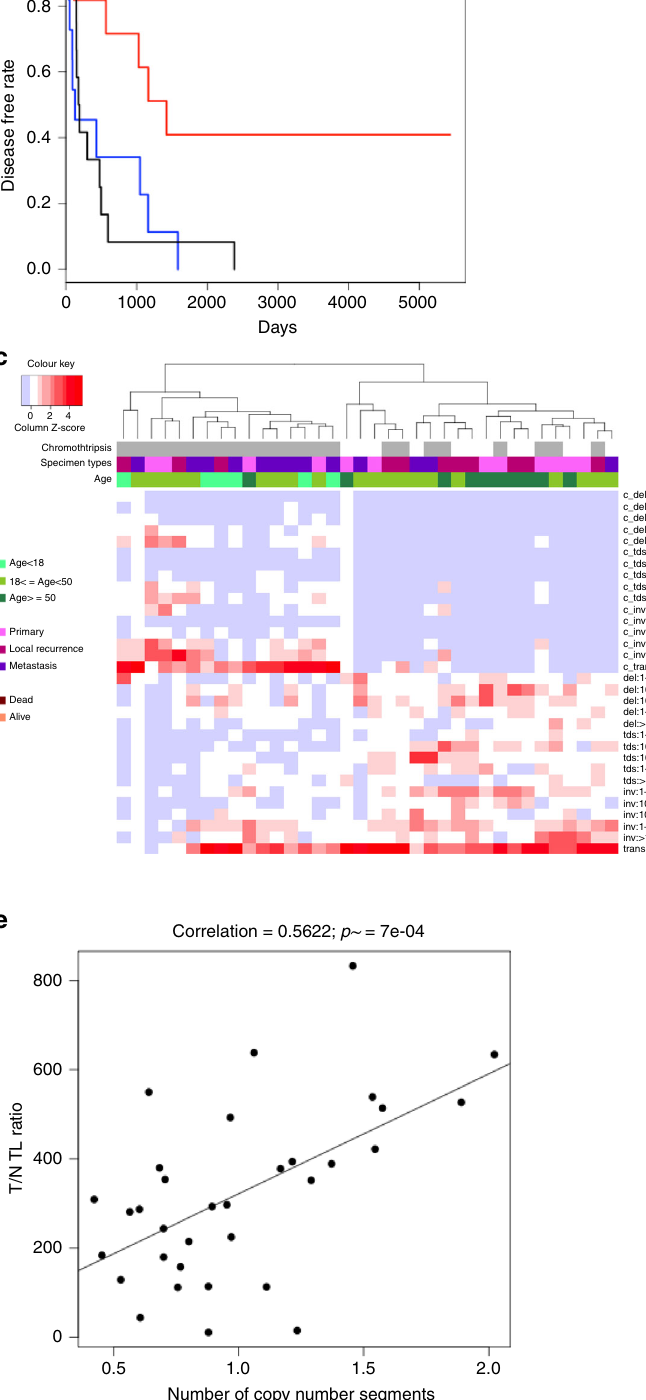
WRN , and HUS1 19 , were also signi fi cantly correlated with telo- mere length ( P < 0.001, P < 0.05, P < 0.05, respectively, Pearson ’ s correlation) (Supplemental Data 6). However, the exact mechan- isms surrounding telomere maintenance in the ALT pathway is unclear. Thus, effect of the telomere-related mutations on ALT are yet to be